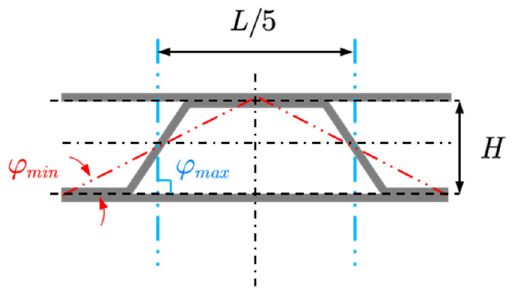
Figure 18. The variation ranges of the stiffener panels.